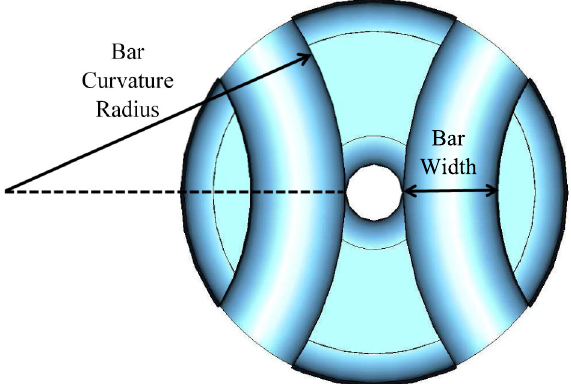
FIG. 18. Design parameters of optimization for the parallel-bar design with cylindrical outer conductor and curved race-track- shaped loading